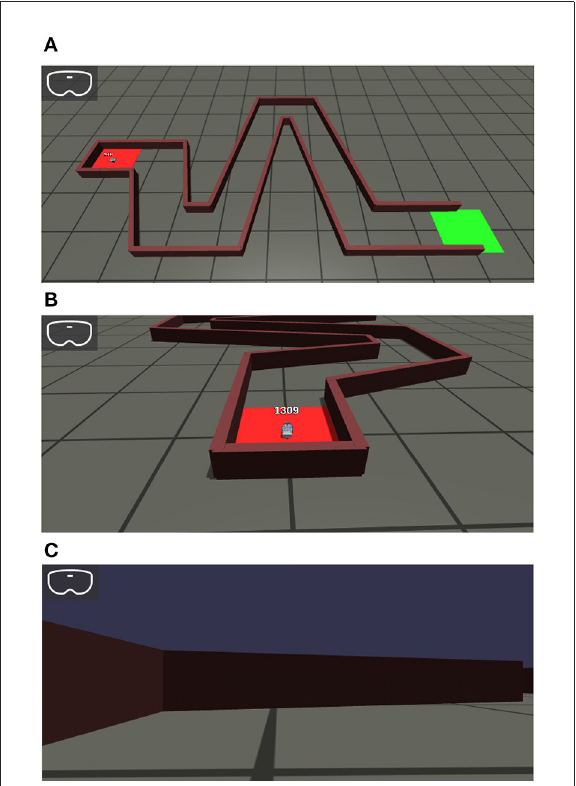
FIGURE4 RoboScape Online 3D view showing "LIDAR road" environment. The robot is in its starting position in the red area. (A) Overview